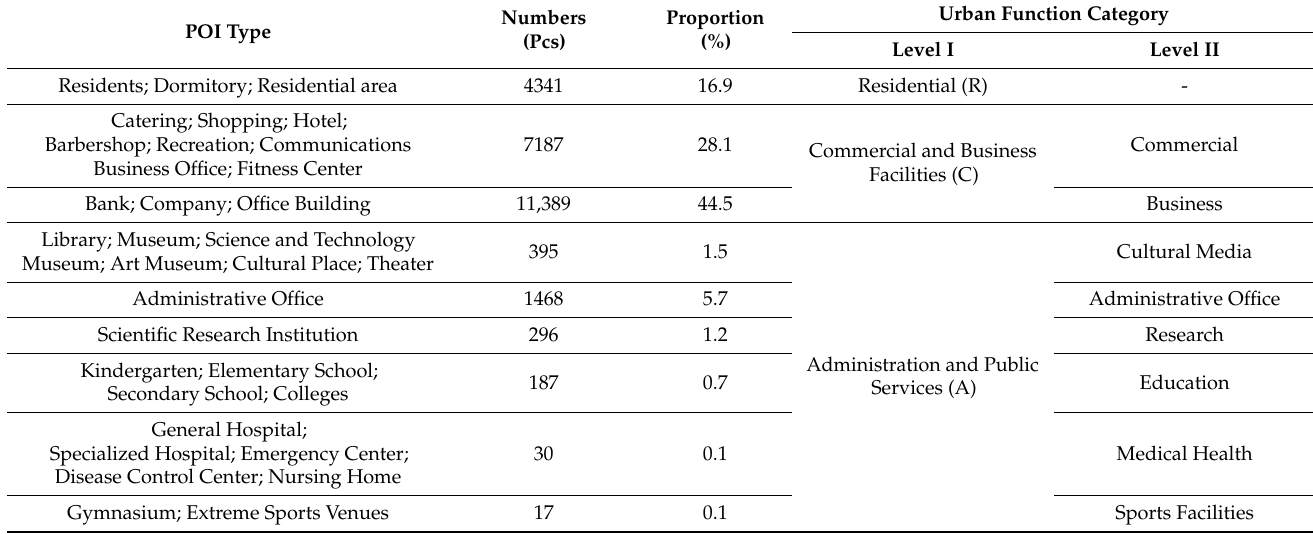
Table 1. Land-use and POI classification